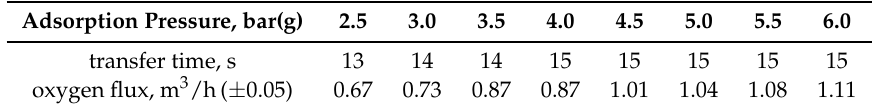
Table 1. Optimum transfer times and corresponding average oxygen flux depending on the adsorption